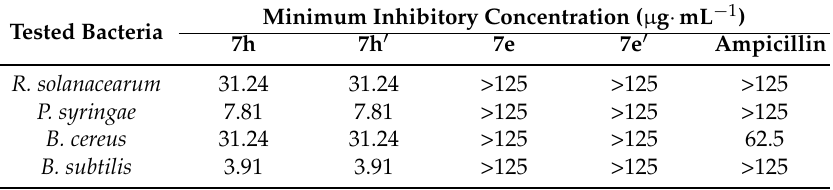
Table 2. The MICs of Four Compounds against the Tested